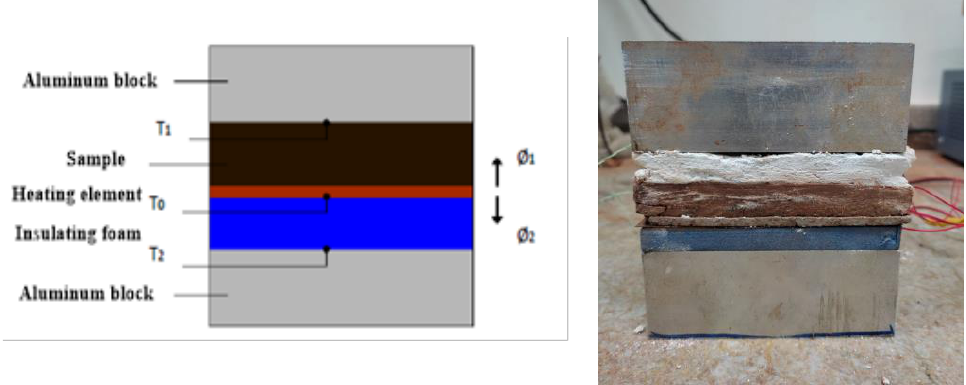
Figure 2. The asymmetrical hot plate method in a steady-state regime.